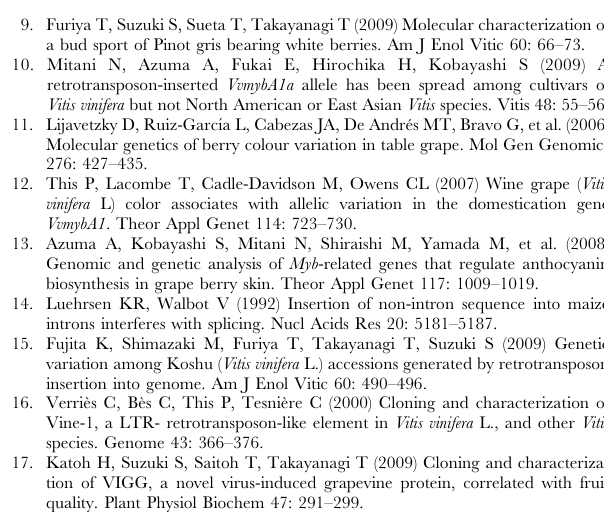
Figure S3 Alignment of nucleotide sequences of MybA1 genes of the red allele among grapes. The 33 bp short fragments in the second intron of the MybA1 gene of oriental V. vinifera cultivars are shaded black. Identical nucleotides are indicated by asterisks. Vfl, V. flexuosa . KS, Koshu. Ryu, Ryugan. HU, Huotianhong. Vshi3, V. shiragai red allele 3. Vsa2, V.